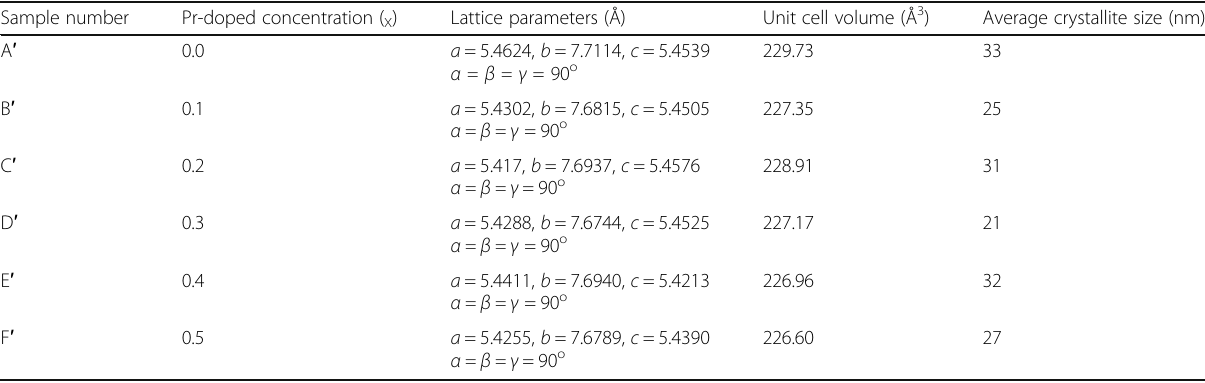
Table 2 The calculated lattice parameters ( a , b , c , α , β , and γ ), unit cell volumes, and average crystallite sizes of the (La 1 − x Pr x ) 0.67 Ca 0.33 MnO 3 nanoparticles post-annealed at 800 °C with different Pr-doped concentrations ( x = 0.0 – 0.5) Lattice parameters within ± 0.0003( a , b , c ) are calculated from the XRD data. Average crystallite sizes within ± 1 are calculated using the Scherrer ’ s